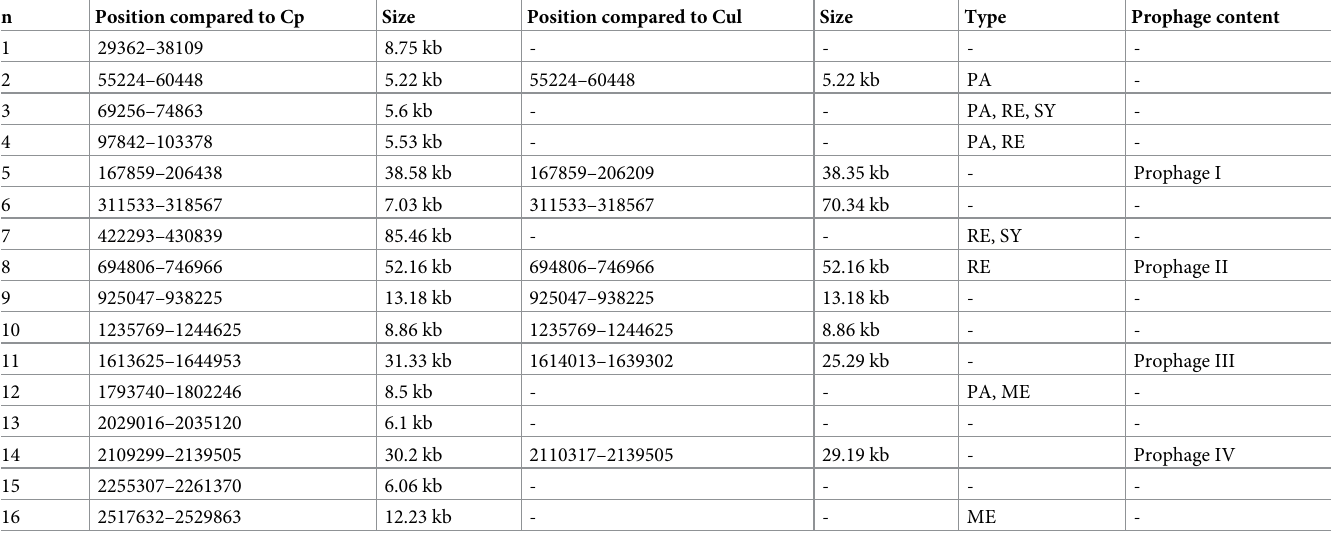
Table 2. Genomic islands in strain PO100/5 compared to Corynebacterium pseudotuberculosis ATCC19410 T and C . ulcerans NCTC7910 T